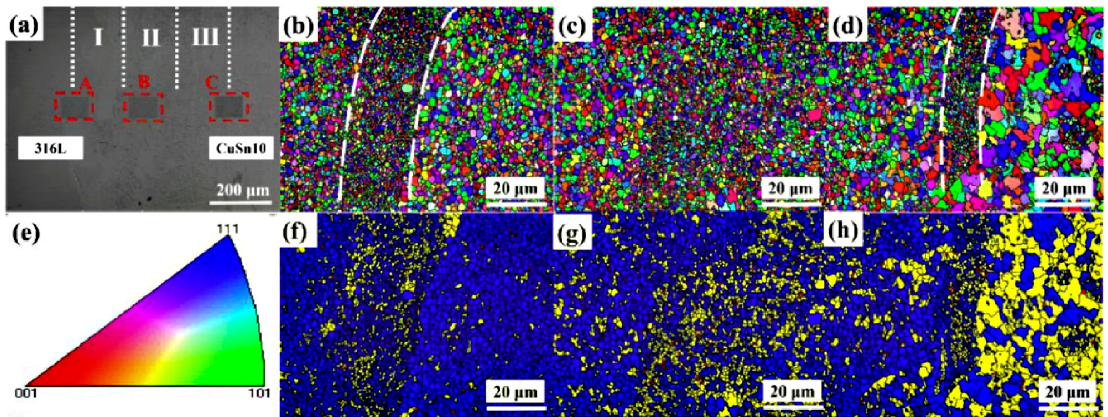
Figure 7. LPBF-processed 316L/CuSn10 specimen, ( a ) SEM image, I, II, III are three main interfacial transion regions, A is the region from 316L to the transition zone, B is the area in the transition zone, C is the area from the transition zone to the CuSn10 alloy; ( b – d ) EBSD orientation maps from A, B and C regions marked by the red dotted frame; ( e ) IPF; ( f – h ) Recrystallisation distribution [105].